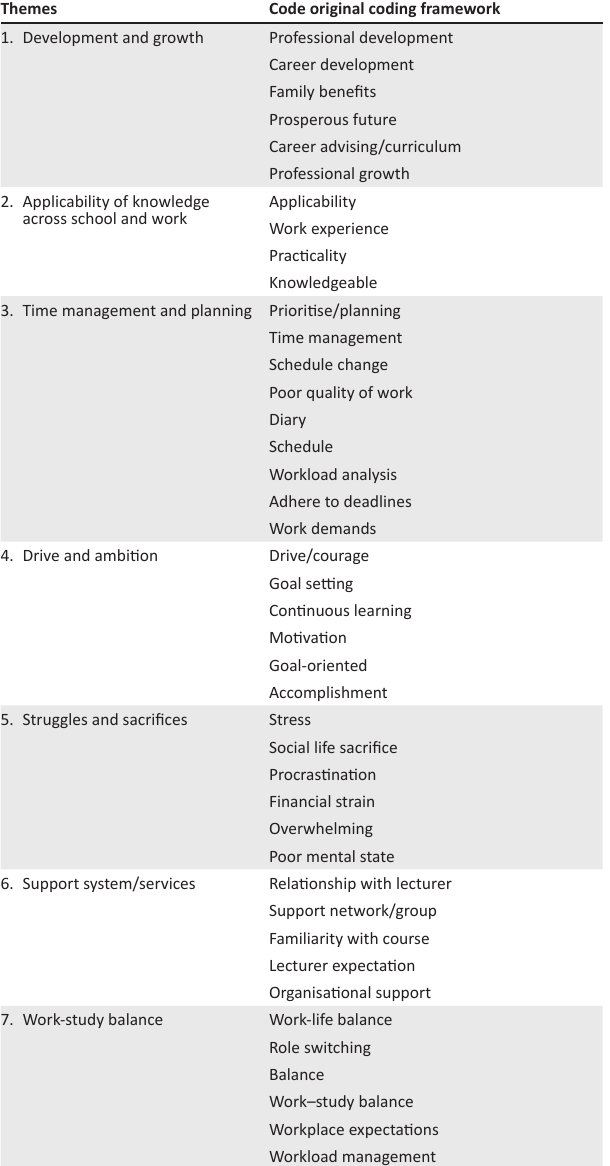
TABLE 3: Seven themes that emerged from the coding of the data. Themes Code original coding